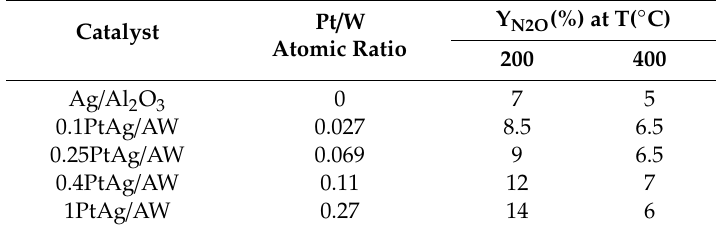
Table 2. N 2 O yield (%) of the PtAg / AW catalysts in C 3 H 8 –SCR of NO with H 2